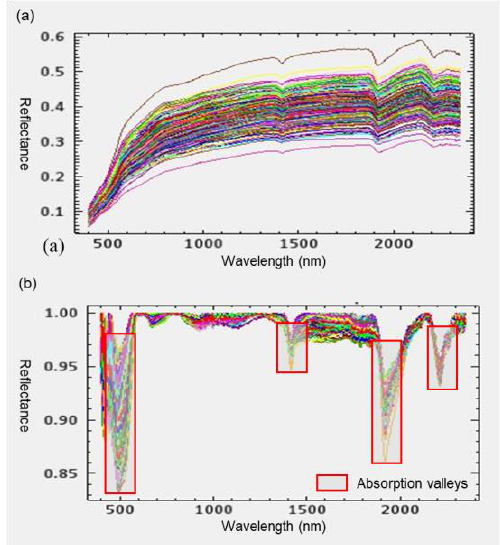
Figure 2. ( a ) Pretreatment spectral curves of the soil samples. ( b ) Continuum removed spectral curves of the soil